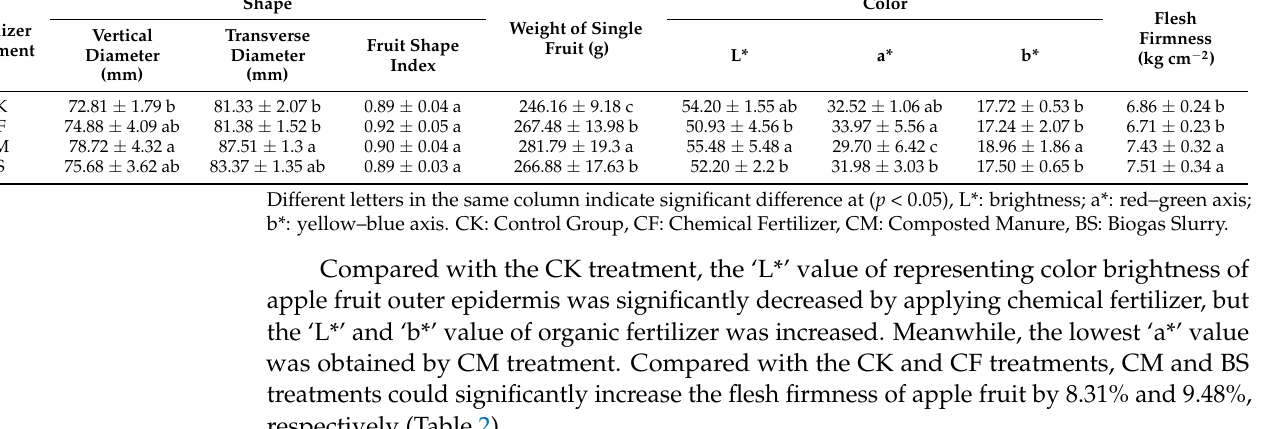
Weight of Single Fruit